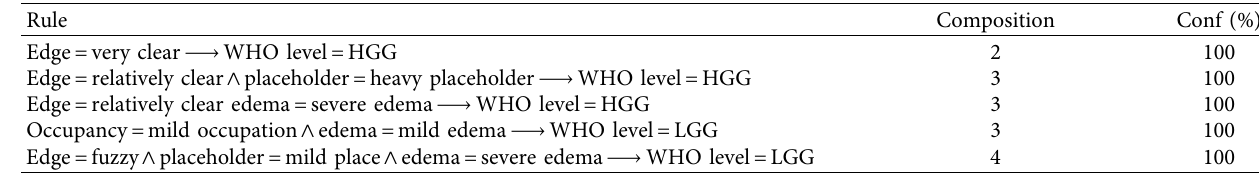
Table rules and inference rules presubstantially are the same as the remaining samples of the resulting test sample were evaluated rule, and the diagnostic rules using the WHO level above an 80% accuracy rate.